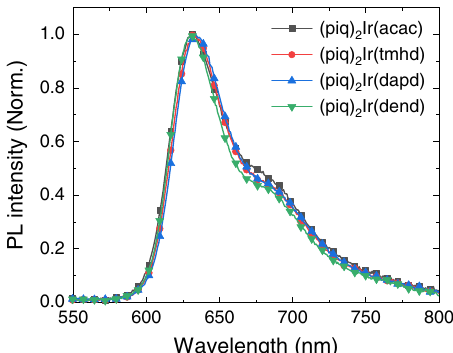
Fig. 4 Normalized photoluminescence spectra of Ir(III) complexes doped in mixed host. The mixed host is composed with the 1:1 mixture of 9,9 ′ - diphenyl-9H,9 ′ H-3,3 ′ -bicarbazole (DP-BCZ) and 5-(3-4,6-diphenyl-1,3,5- triazin-2-yl)phenyl-3,9-diphenyl-9H-carbazole